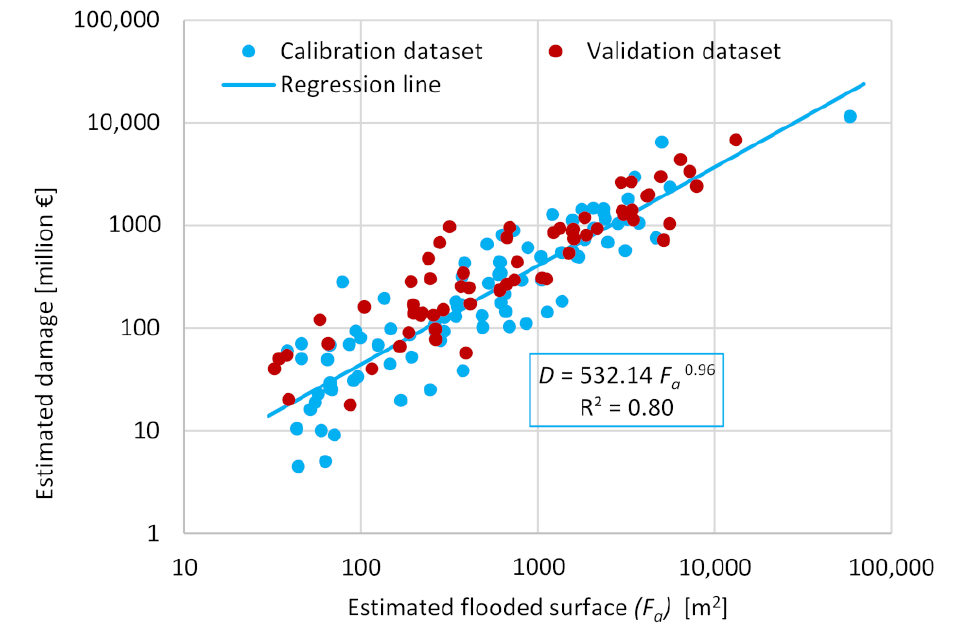
Figure 5. Regression model and equation obtained on damage data for the five regions of southern Italy: each point represents a single municipality. The model (blue line) has been derived from the calibration dataset (blue dots); red dots represent validation data that fit quite well to the